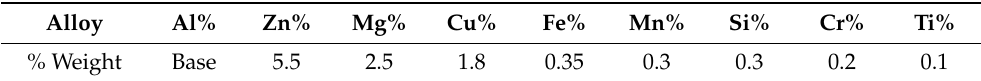
Table 1. Al 7075 chemical composition (weight).